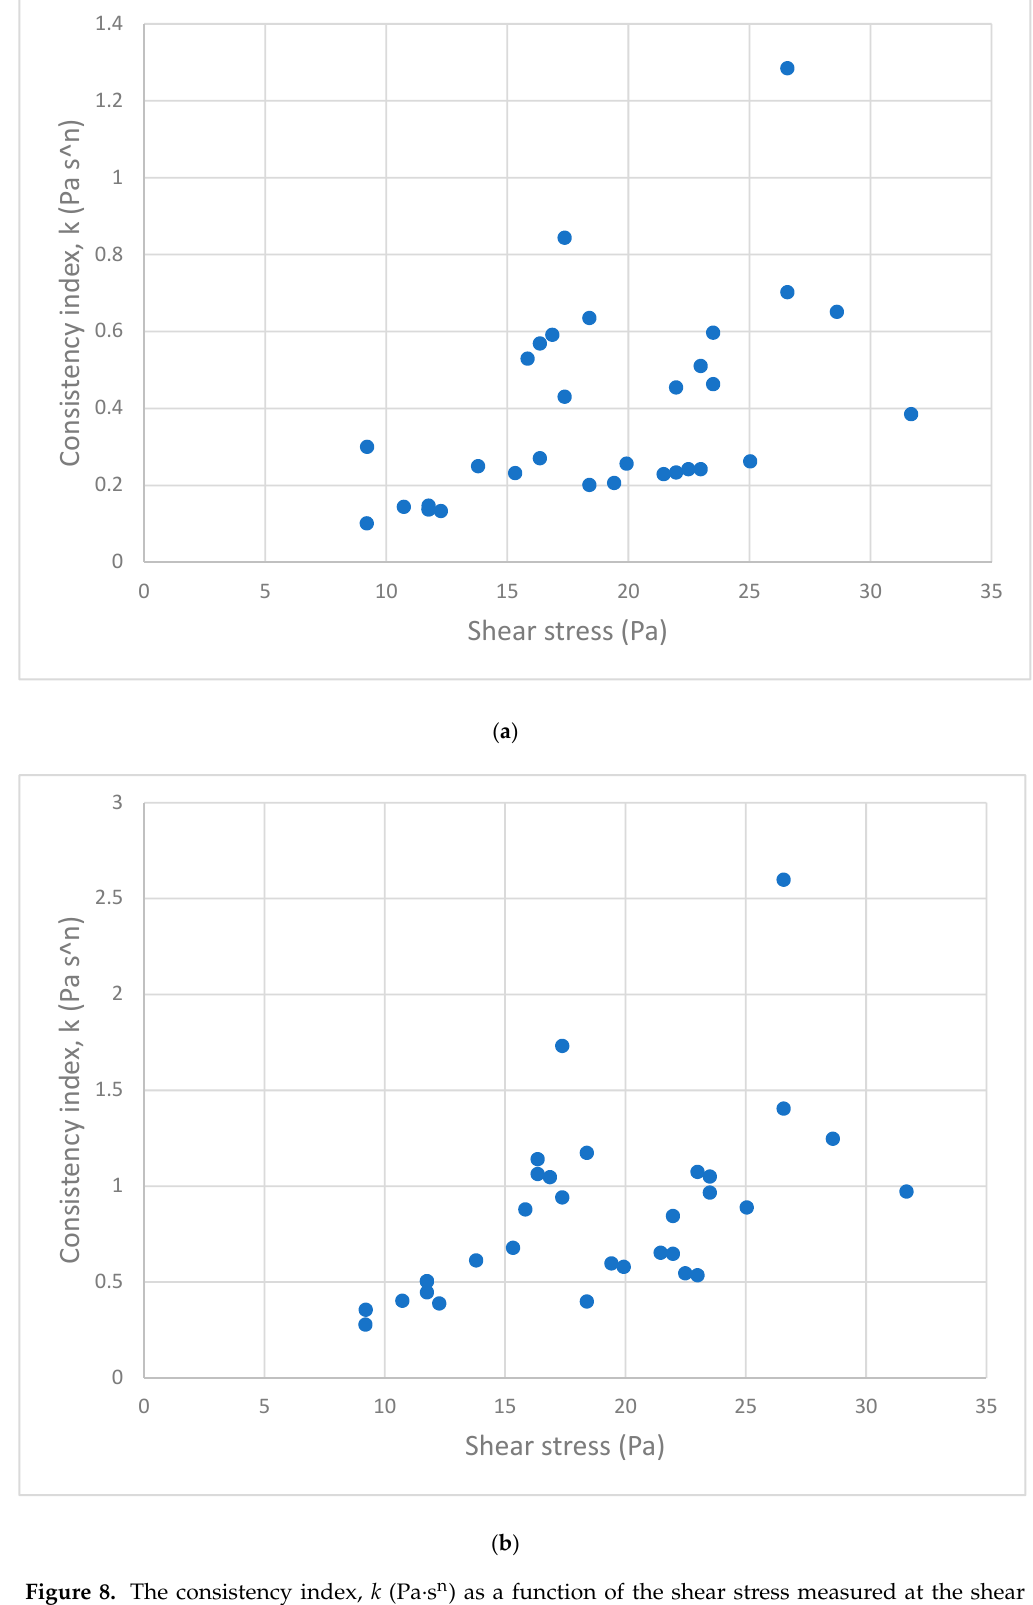
Figure 8. The consistency index, k (Pa . s n ) as a function of the shear stress measured at the shear rate of 170.3 1/s for a large number of drilling fluids. Shear stresses in Pa. (a) Upper figure – The Herschel-Bulkley model consistency index; (b) Lower figure – The power law model consistency index.